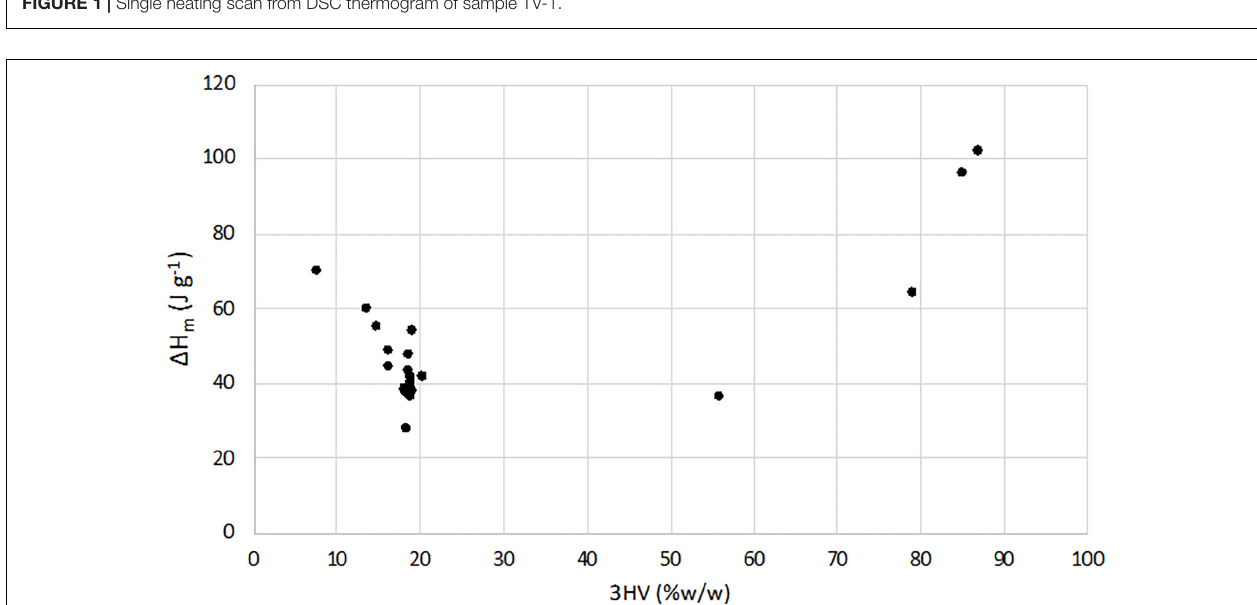
FIGURE 1 | Single heating scan from DSC thermogram of sample TV-1.